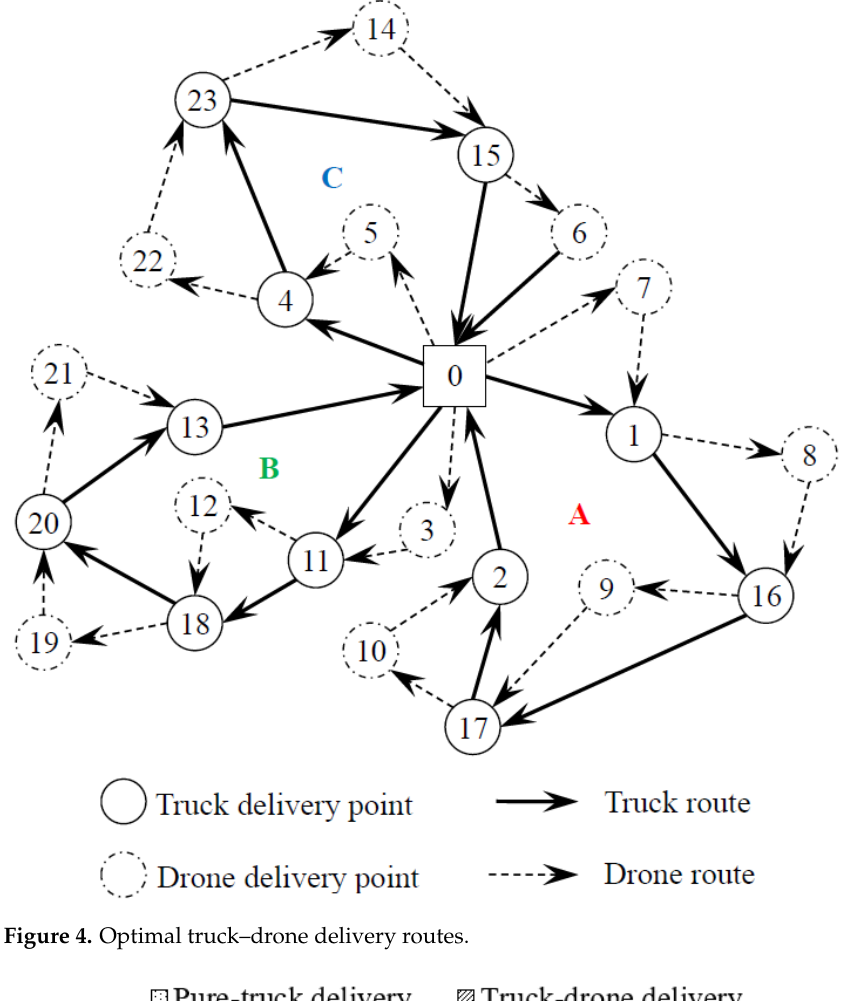
Figure 4. Optimal truck–drone delivery routes.